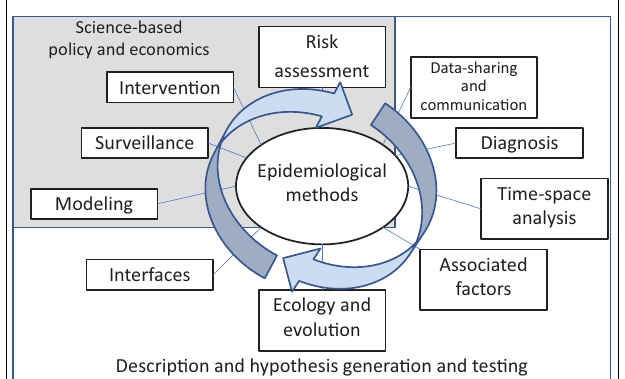
FIGURE 1 | Suggested pathway for the systematic assessment of the epidemiological dynamics of infectious diseases